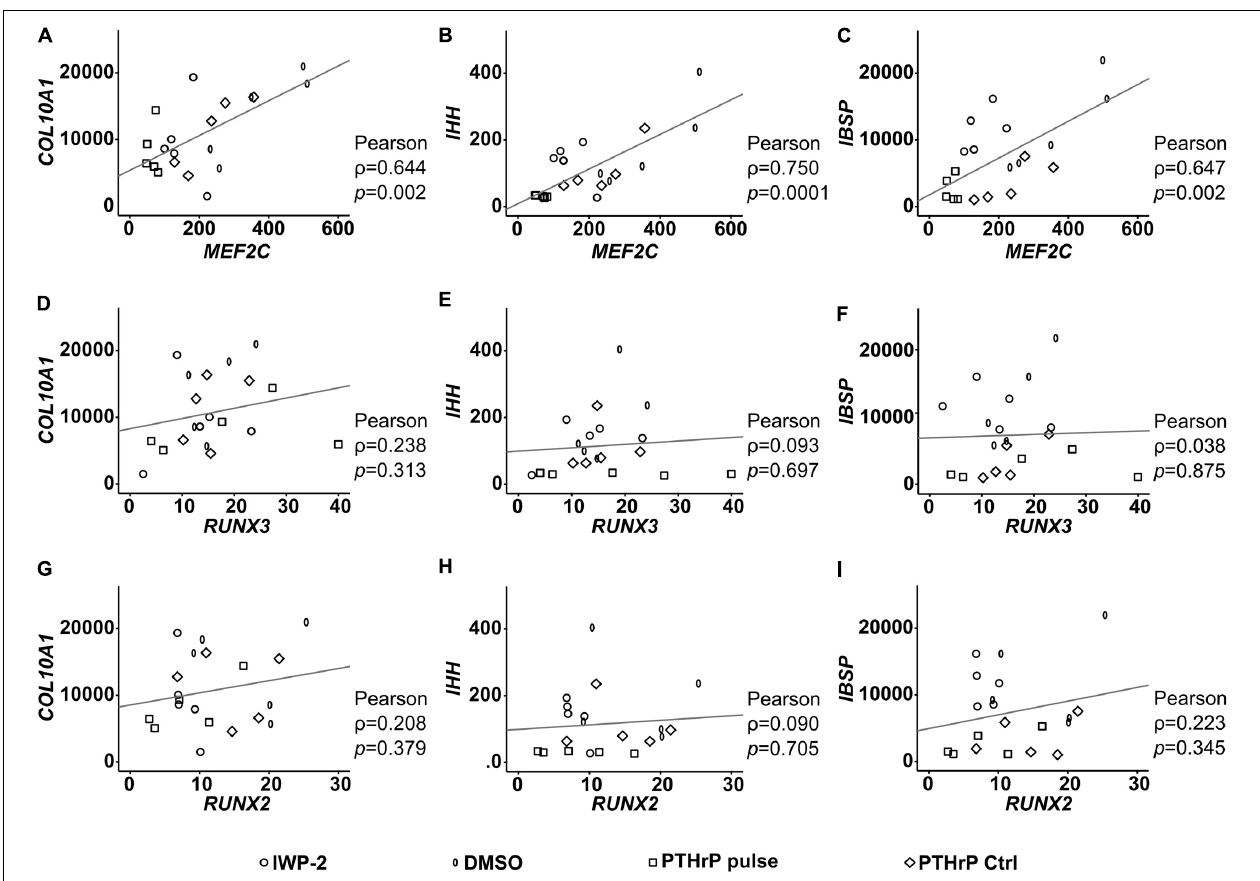
FIGURE 9 | Correlation of RUNX2, RUNX3, and MEF2C with hypertrophic marker gene expression after lineage shift (WNT/HH inhibition). (A–I) Pearson correlation between the expression levels (% reference gene) of RUNX2 , RUNX3 , MEF2C and the hypertrophic genes COL10A1 , IHH , and IBSP at indicated treatments,